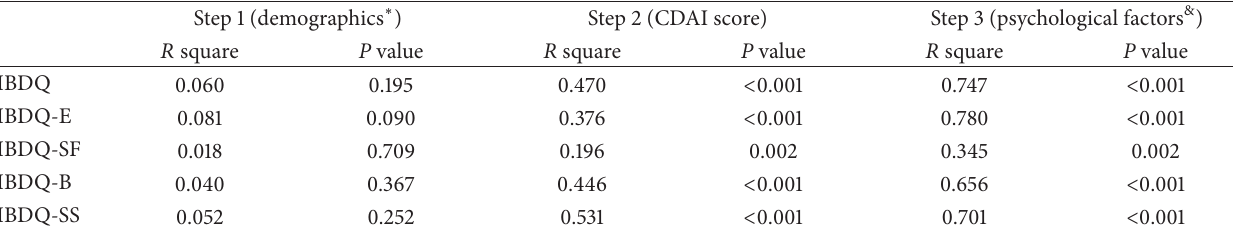
Table 1: Analysis of potential confounding parameters in the relationship between psychological factors and HRQoL in patients with Crohn’s